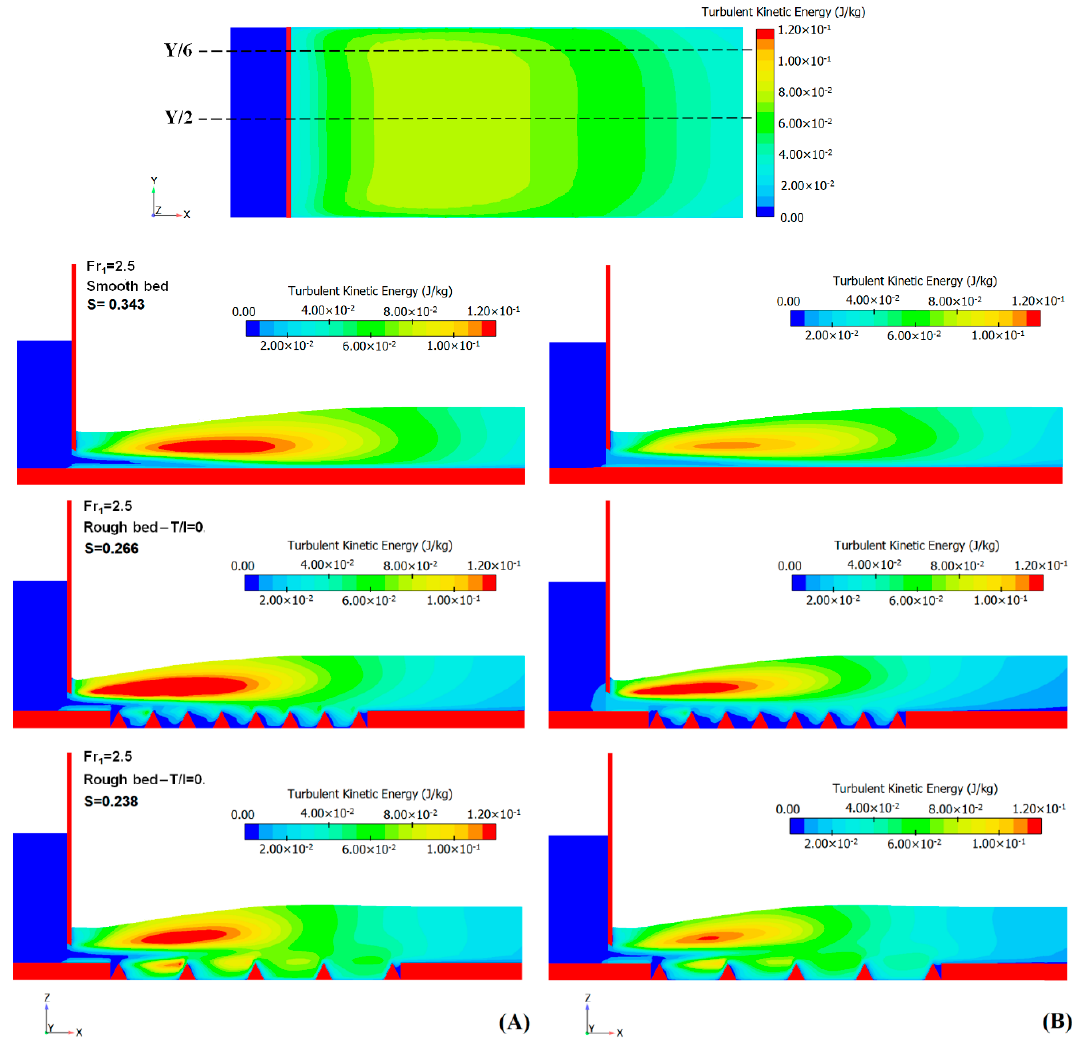
Figure 17. Longitudinal turbulent kinetic energy distribution on the smooth and triangular macroroughnesses: ( A ) Y/2 ; ( B ) Y/6.